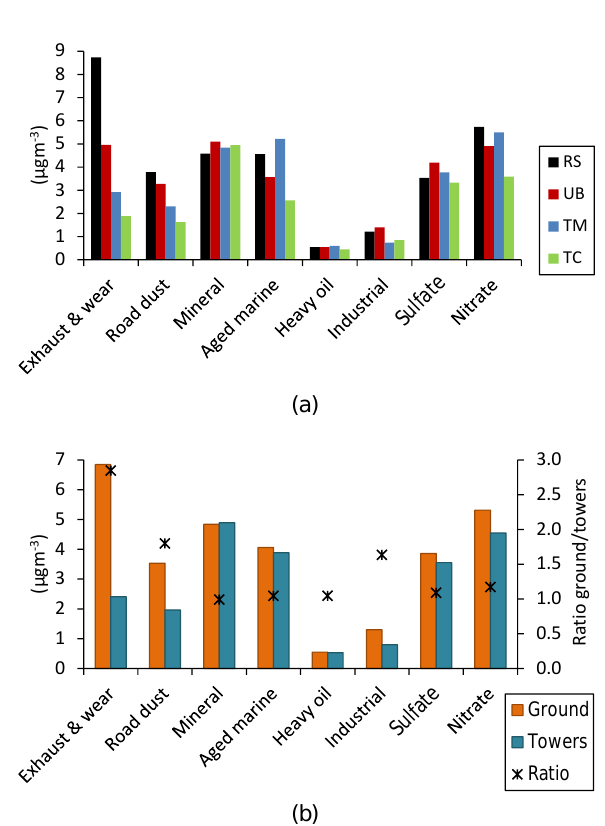
Figure 5. Contribution to PM 10 concentration levels of each of the eight factors: (a) at each of the 4 sites (RS, UB, TM, TC) and (b) at ground (RS and UB) and tower levels (TM and TC) and the con- centration ratio between ground and tower sites during the SAPUSS